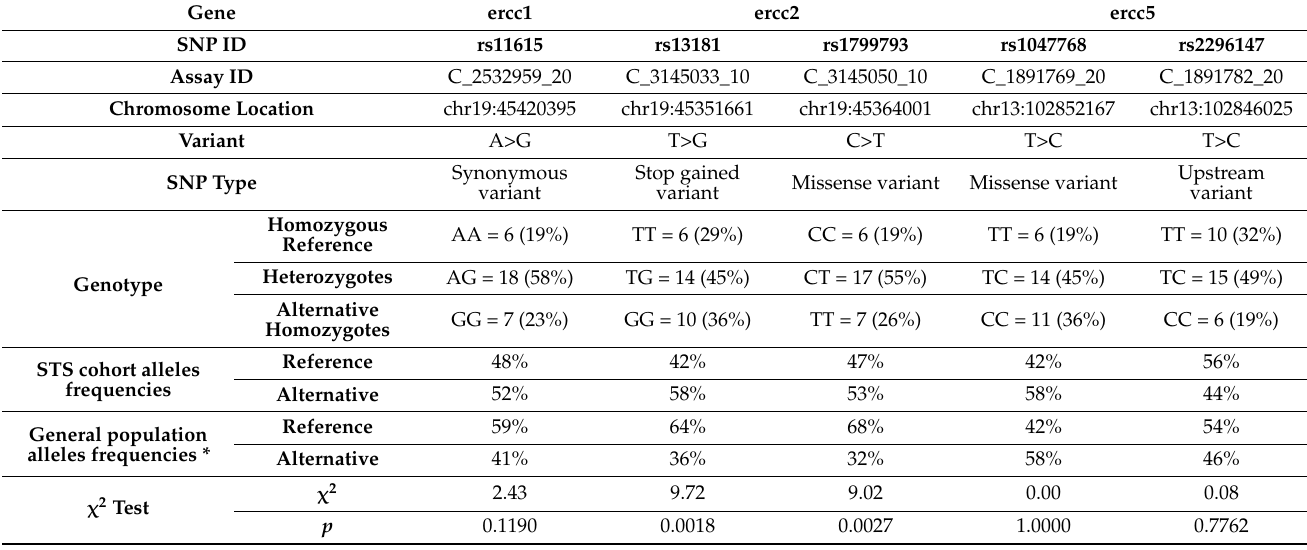
Table 3. Allelic and genotypic frequencies of SNPs in DNA extracted from buccal